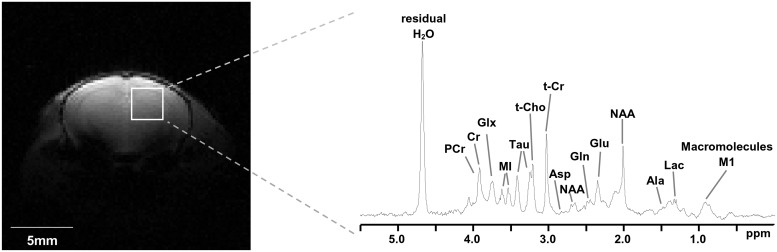
In vivo brain metabolite content determined by 1H-MRS.Localized 1H spectra were obtained from an 18.75 μl volume (white box) positioned within the left or right hemisphere of the brain. Metabolite content was determined by spectral fitting with LC model using a basis set of 17 metabolites plus components due to macromolecules and intracellular lipids.